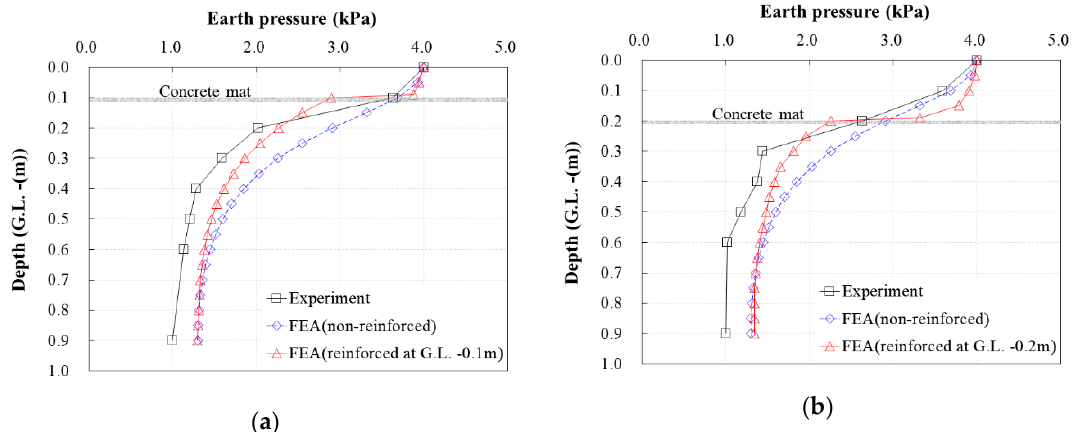
Figure 8. Comparison of the experimental and FEA results for the reinforced concrete mat: ( a ) case of reinforcement at G.L. − 0.1 m; ( b ); case of reinforcement at G.L. − 0.2 m.